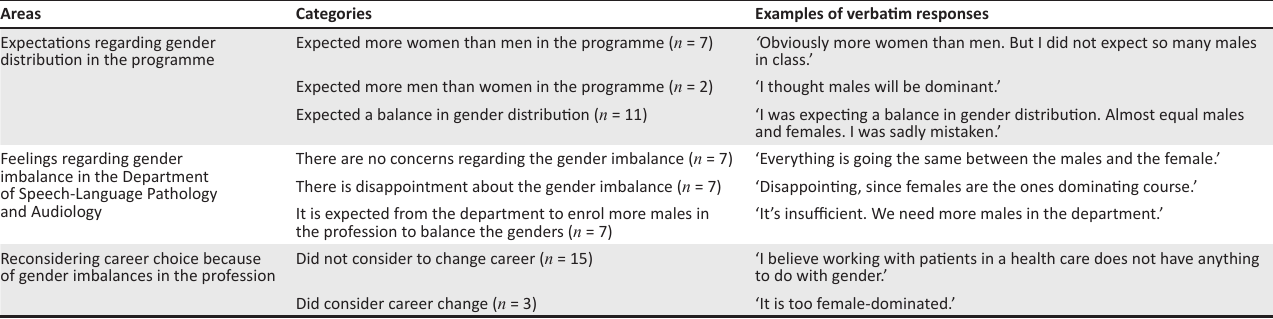
TABLE 3: Gender distribution in the specific